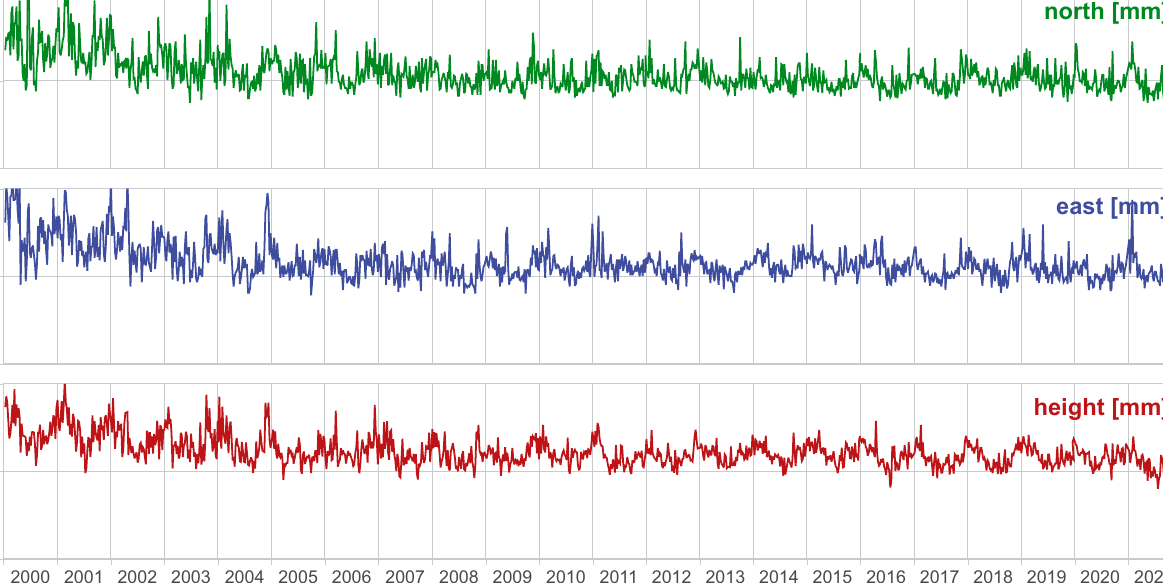
Figure 14: Mean RMS values of the station position residuals obtained after comparing the SIRGAS - Repro2 station positions between consecutive